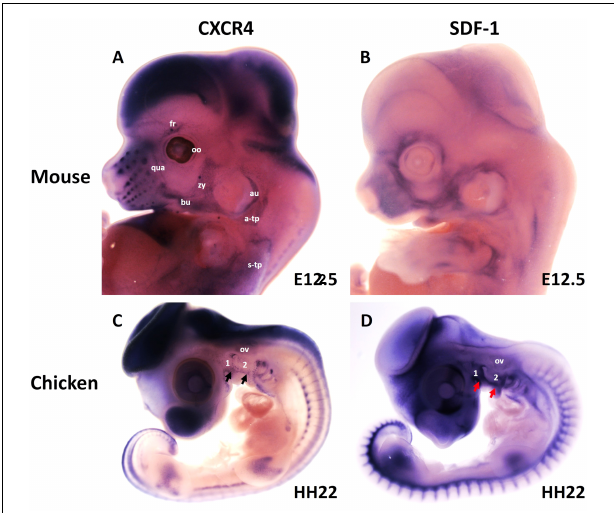
FIGURE 5 | Expression of CXCR4 and its ligand SDF-1 during head and neck muscle development. (A,B) Whole-mount in situ hybridization of CXCR4 (A) and SDF-1 (B) in mouse embryos at E12.5. Note labeling of BA2-derived muscles anlage (fr, bu, oo, zy, au, qua) by CXCR4. CXCR4 is also expressed in non-somitic neck muscles (a-trap, s-trap). SDF-1 is expressed in the adjacent mesenchyme of the face. (C,D) Whole-mount in situ hybridization of CXCR4 (A) and SDF-1 (B) in chicken embryos at HH22. CXCR4 and SDF-1 are expressed in complementary patterns in the chicken branchial arches. Black and red arrows mark CXCR4 and SDF-1 in the BAs. a-trap, acromio-trapezius; au, auricularis; BA1-2, branchial arches 1–2; bu, buccinator; fr, frontalis; oo, orbicularis oculi; ov, otic vesicle; qua, quadratus labii; s-trap, spino-trapezius; zy,